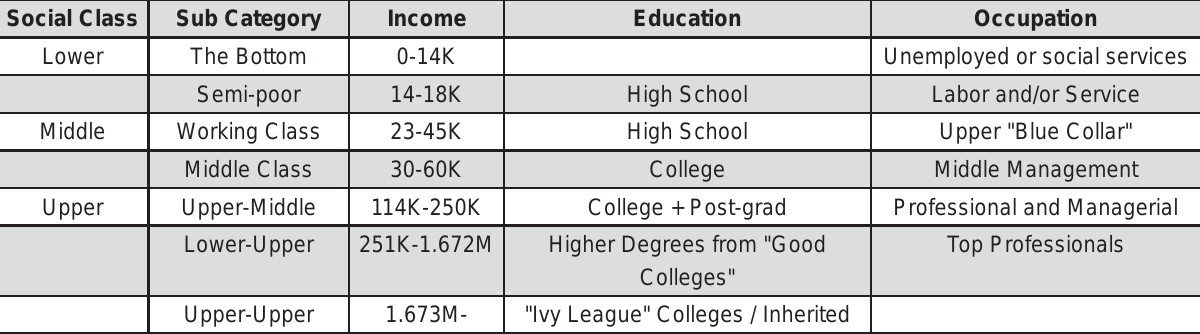
Figure 1- The Coleman-Rainwater Social Class